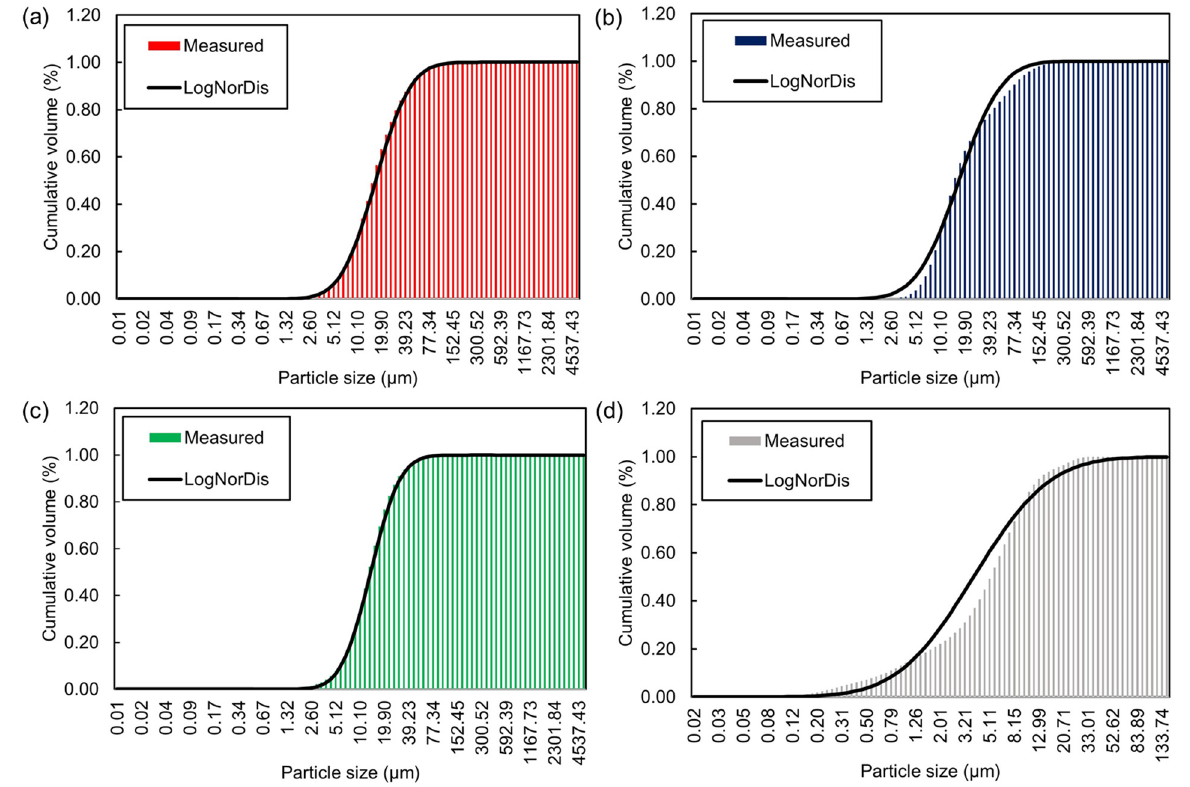
Figure 5. Log-normal distributions of the cementitious materials: ( a ) PC; ( b ) FA; ( c ) BS; ( d ) SF. Table 6. Estimated radius of curvature ( a ∗ ), percolation volume fraction ( φ 0 ), and maximum solid volume fraction ( φ m